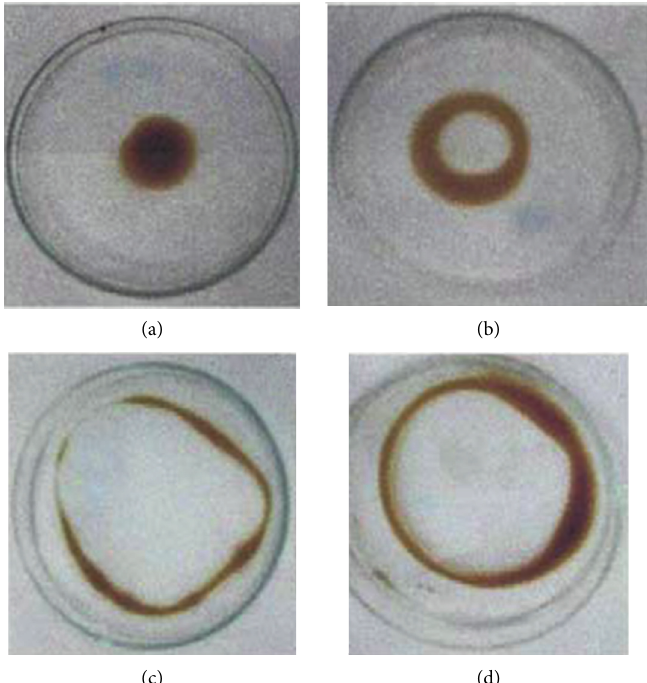
Figure 3: Dispersion area of the burned motor oil according to the compound used: distilled water (a), commercial detergent (b), Tween 80 (c), and crude bioemulsifier produced by Stenotrophomonas maltophilia UCP 1601 (d).